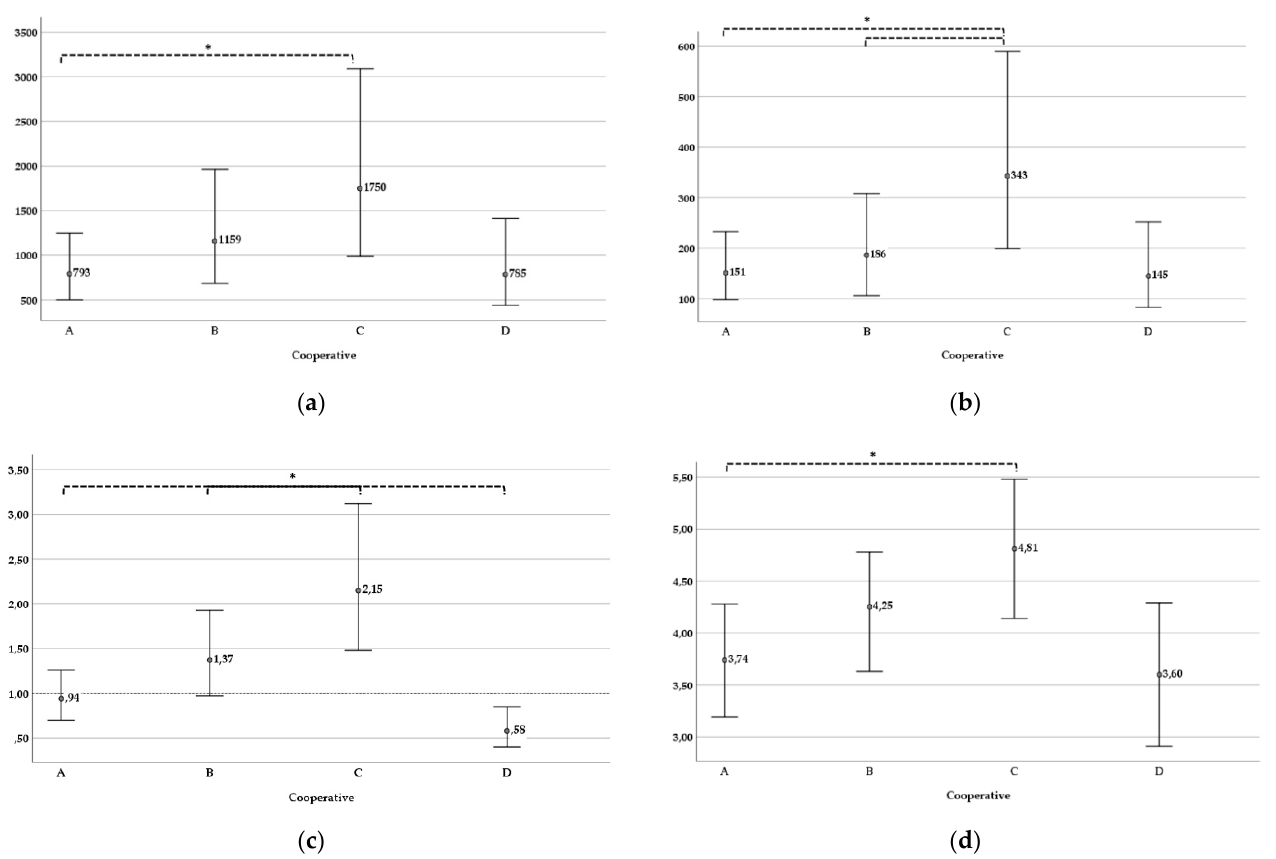
Figure 2. ( a ) WTP LS (in FRW); estimated marginal means and 95% confidence interval, per cooperative [* difference is significant ( p < 0.05) in pairwise comparison]; ( b ) WTP PRO (in FRW per are); estimated marginal means and 95% confidence interval, per cooperative [* differences are significant ( p < 0.05) in pairwise comparison]; ( c ) WTP LS /(WTP PRO * are); estimated marginal means and 95% confidence interval, per cooperative [* all pairwise differences are significant ( p < 0.05)]; ( d ) Willingness to invest time in Bti spraying (extra hours per week); estimated marginal means and 95% confidence interval, per cooperative [* difference is significant ( p < 0.05) in pairwise comparison].